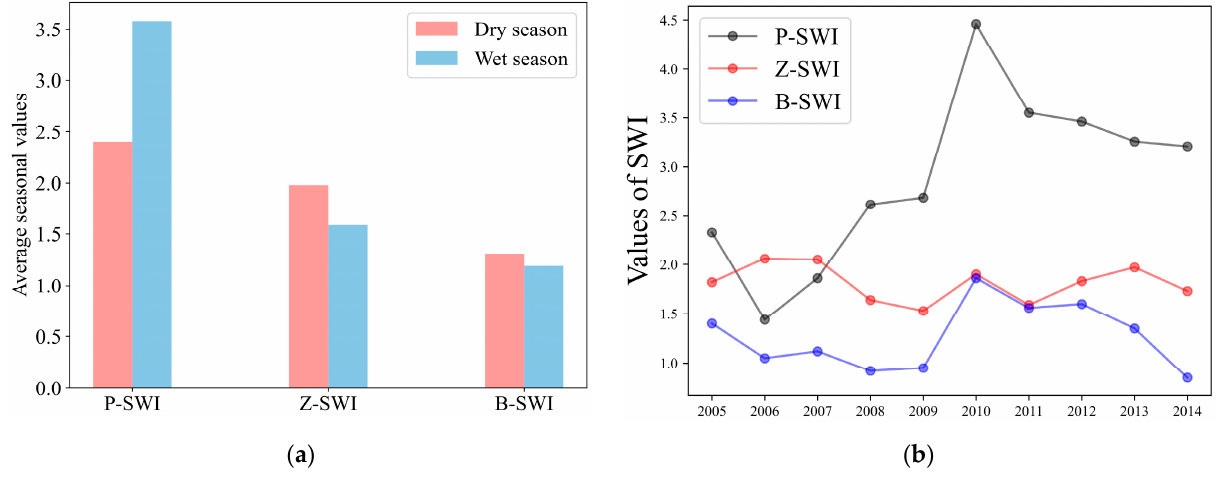
Figure 6. The variation of the P-SWI , Z-SWI , and B-SWI. ( a ) Seasonal variation. ( b ) Inter-annual